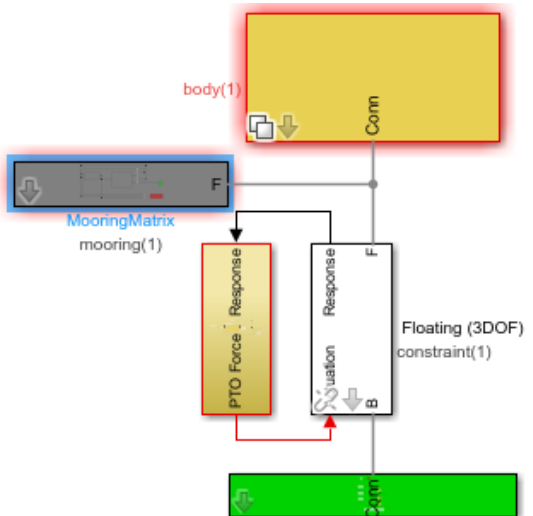
Fig. 4: The top level of the WEC-Sim model of the WaveBot device. The surge restoring spring is included as the mooring block, and the floating (3DOF) con- straint applies the controller actuation to the body as prescribed by the PTO Force output, based upon measurements of the device response.